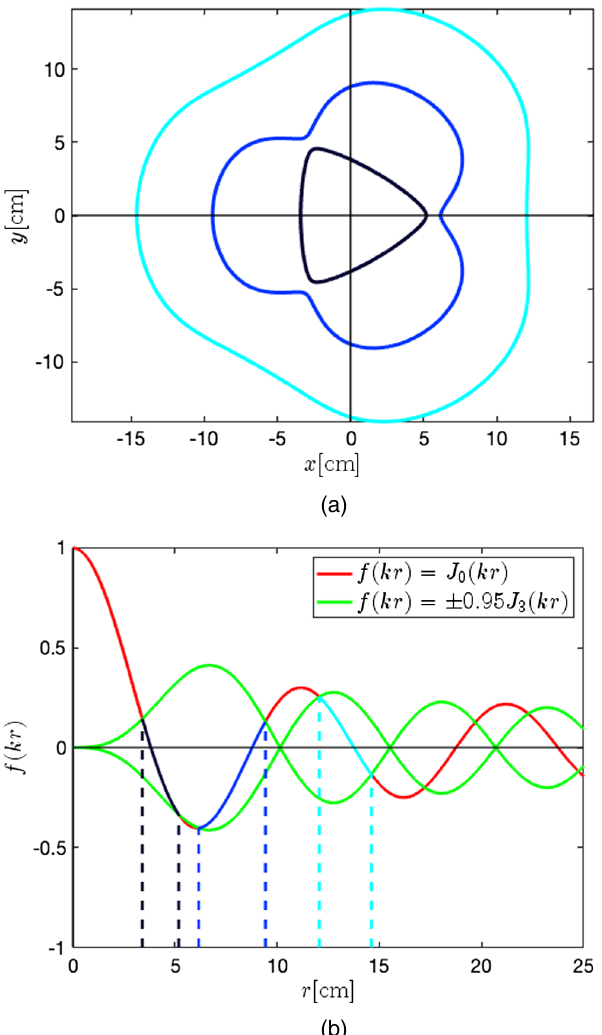
FIG. 3. 3 GHz TM modes with ˜ g 3 = ˜ g 0 ¼ 1 . 2 and ϕ 3 ¼ 0 . f 0 ; 3 g η 0 η Þ θ Þ , that support the η ¼ 1 , 2, and 3 (a) The cavity shapes, r ð 0 ð TM modes as black, blue, and cyan lines respectively. f 0 ; 3 g η 0 (b) J 0 ð kr Þ and − 1 . 2 J 3 ð kr Þ cos 3 θ plotted against r for θ ¼ 0 , π = 3 . The η ¼ 1 , 2, and 3 solutions where the two functions intersect for all θ are plotted as black, blue, and cyan